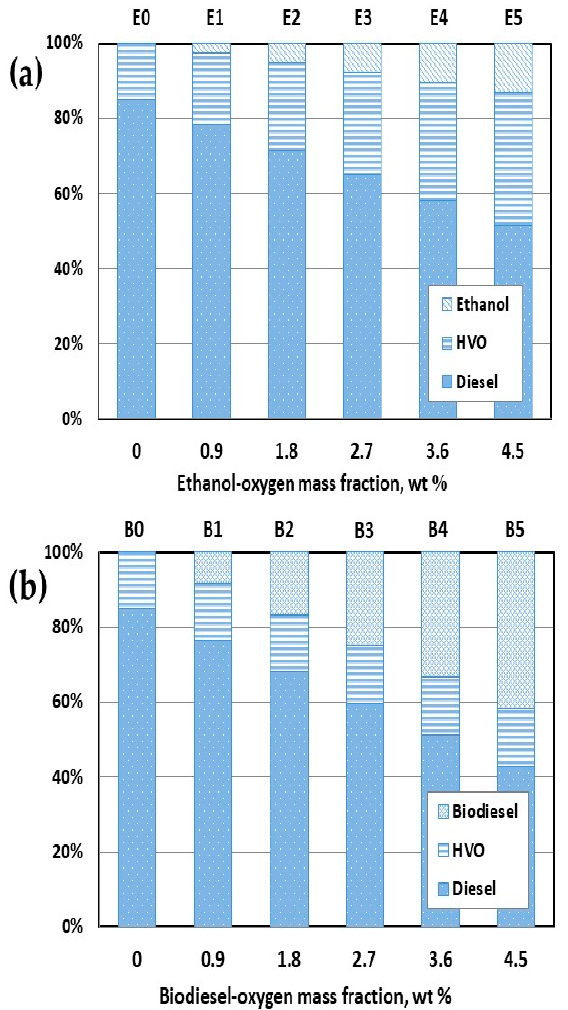
Figure 3. Composition of the experimental diesel–HRD fuel blends oxygenated with ethanol ( a ) or biodiesel ( b ) and purposely designed with an aim to achieve a wide variation range of 0–4.52 wt% of fuel-oxygen mass content (as listed in nomenclature), but still preserving the same blended cetane number value of 55.5.